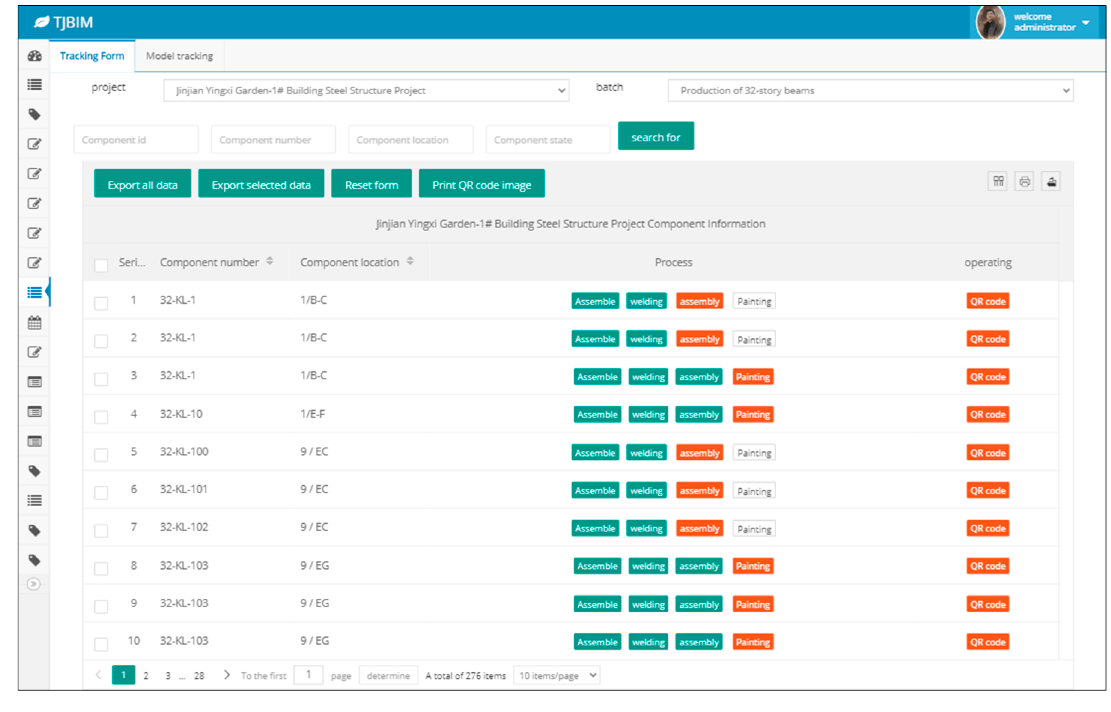
Figure 9. Component trace.